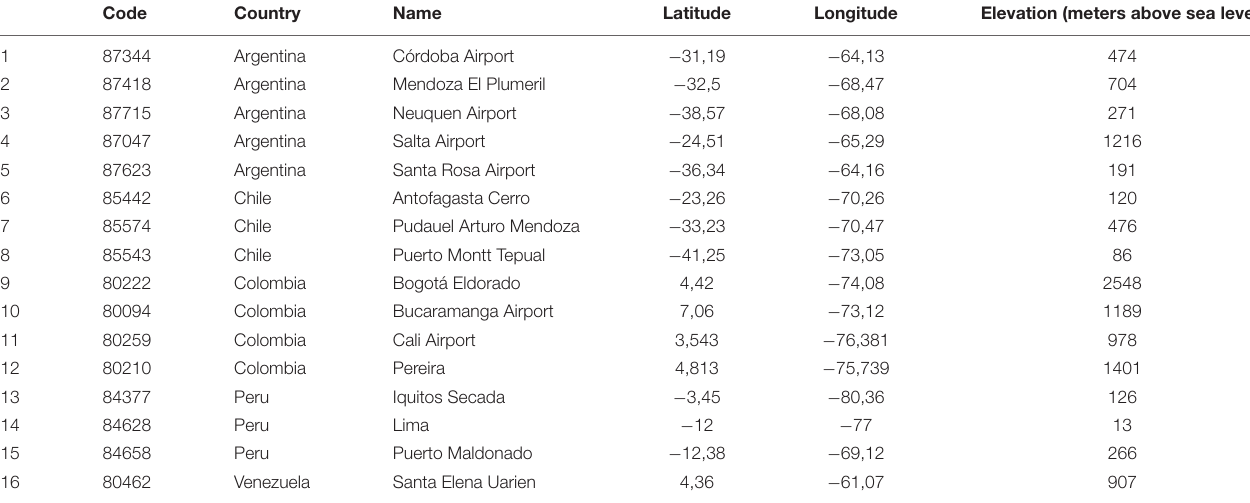
TABLE 3 | Stations with upper air measurements located in the Andes region or in nearby adjacent